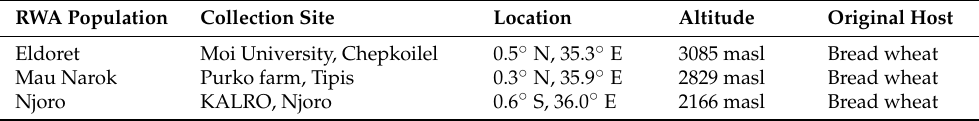
Table 1. Russian wheat aphid populations used in the study and their collection sites and original hosts. RWA, Russian wheat aphid; KALRO, Kenya Agricultural and Livestock Research